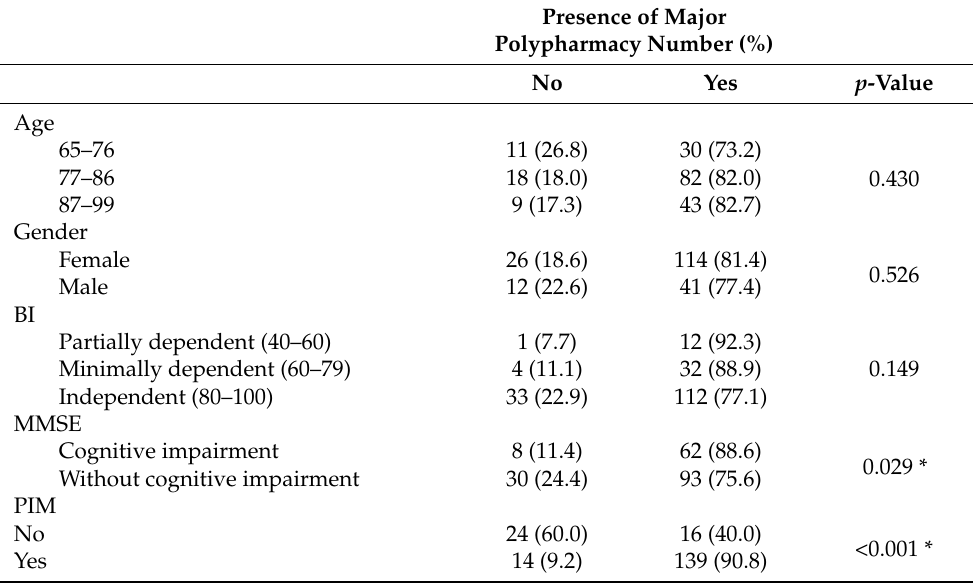
Table 3. Association between polypharmacy and functionality for daily living, cognition and the presence of potentially inappropriate medication.